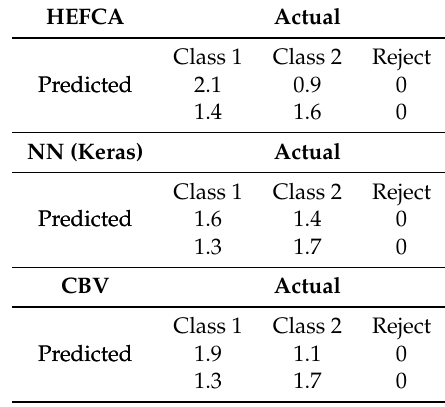
Table 9. Confusion matrixes for the “Liked”